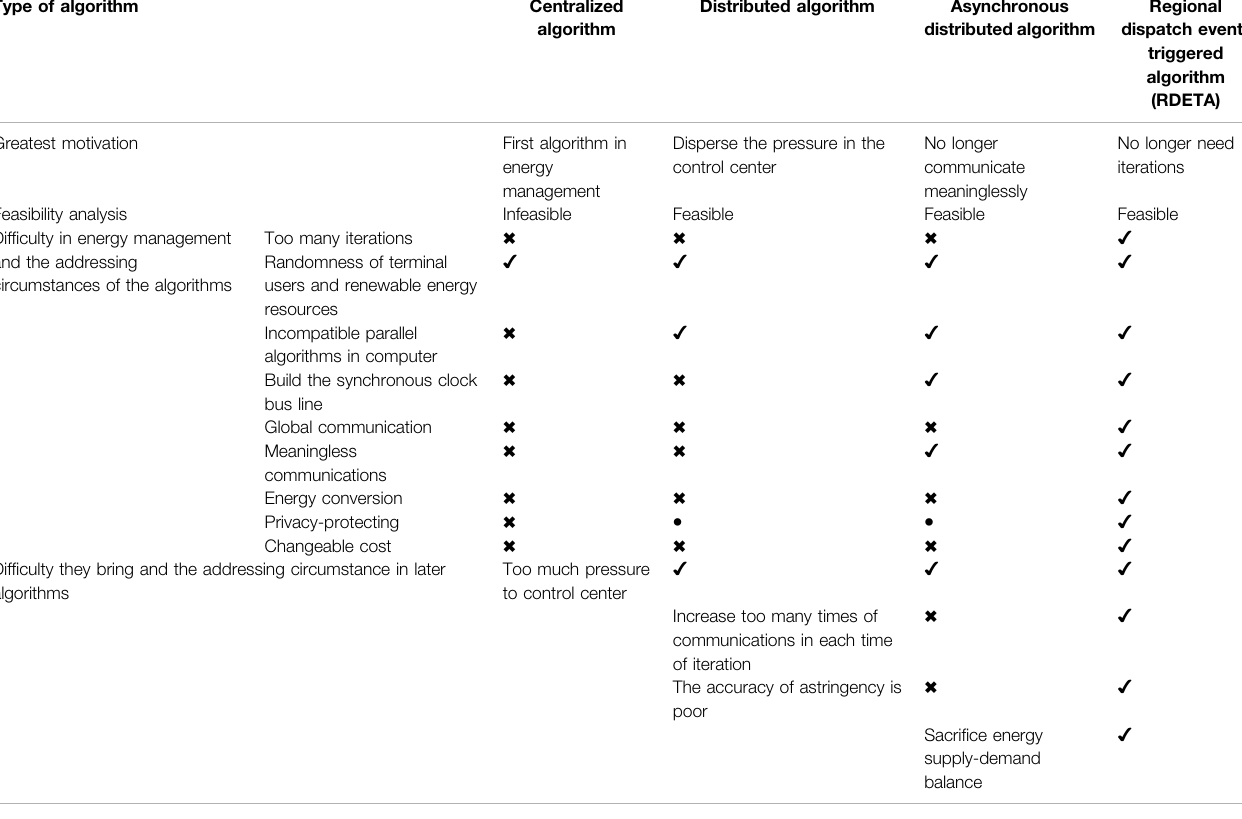
TABLE 1 | The development and contributions of an energy management algorithm.